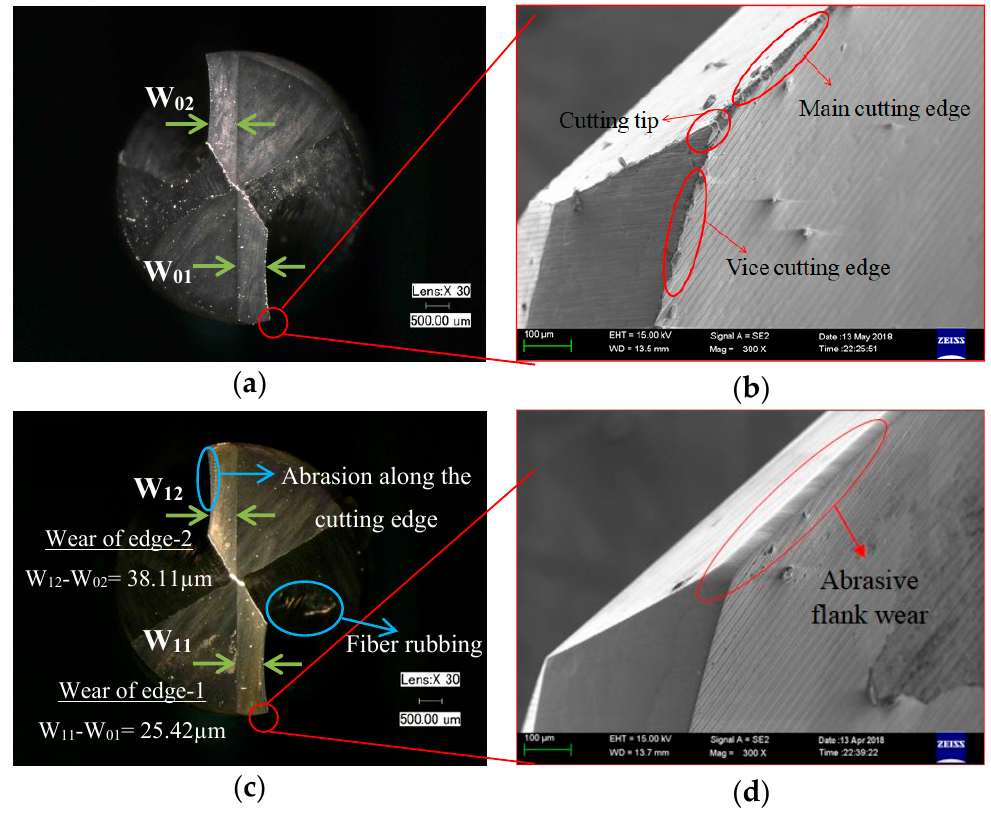
Figure 5. Microscopic and SEM images showing cutting tip and main cutting edge: ( a ) and ( b ) before; ( c ) and ( d ) after drilling 30 holes with cutting speed of 9000 rpm and feed rate of 400 mm/min.